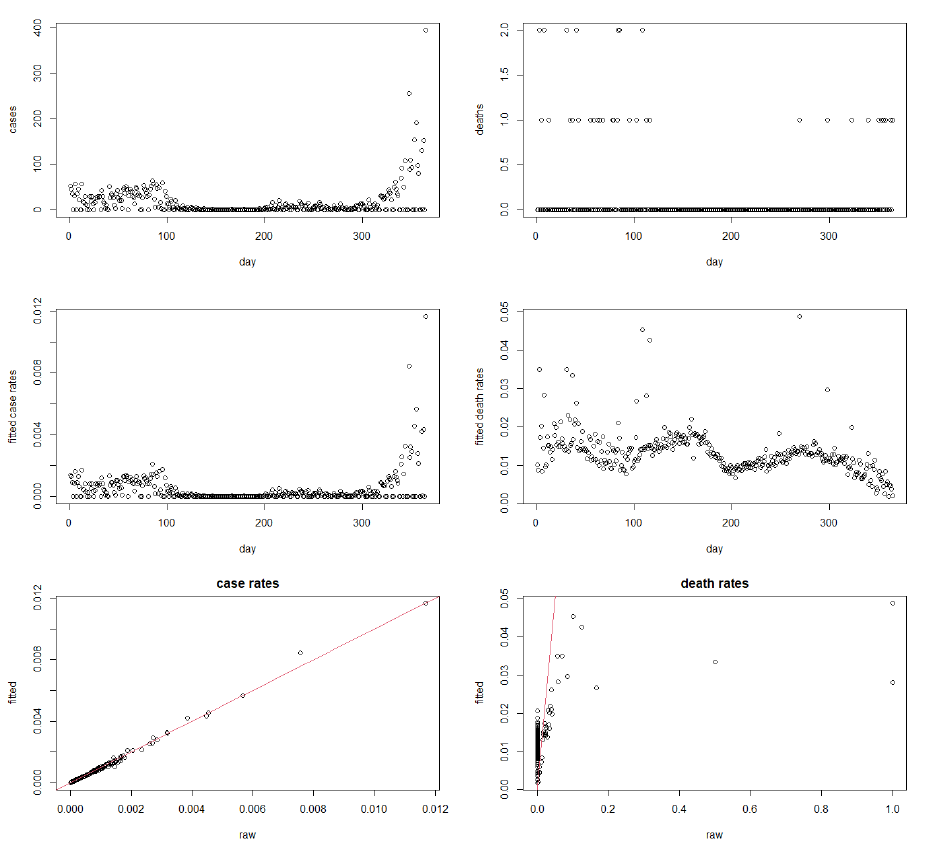
Figure 1. Top : daily COVID-19 cases ( left ) and deaths ( right ) in San Marino in 2021; middle : fitted daily COVID-19 rates ( left ) and death rates ( right ) in San Marino in 2021; bottom : fitted versus raw case rates ( left ) and death rates ( right ) in San Marino in